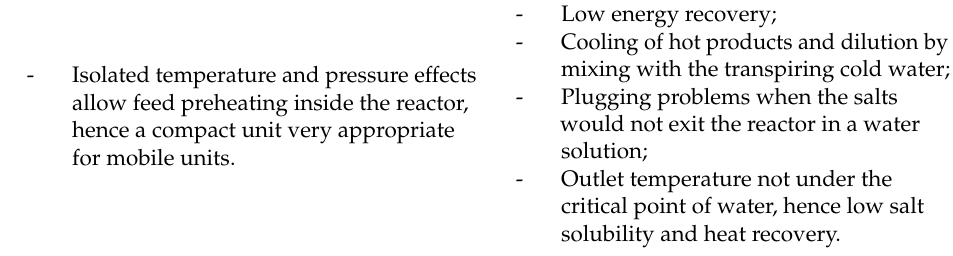
Table 5. Comparison of advantages and disadvantages of the described reactors. Figure Main Advantages Main Disadvantages - Easy implementation by simple available tube soldering; - Suitable for high pressure due to Figure 9 high-rise area compared to volume; - Control of the residence time of the effluent and its conversion rate. - Reduced corrosion problems, overcoming salt deposition; Figure 10 - Achieved short residence times required by hydrothermal oxidation using high flow rates - Particularly sensitive to the problem of Figure 11 solid deposits and clogging, due to very high fluid velocities; - Good control of the exothermic heat of reaction and thus treat a larger quantity Figure 12 of waste; - Tubular reactor with multi-injections of oxygen - Isolated temperature and pressure effects allow feed preheating inside the reactor, Figure 13 hence a compact unit very appropriate for mobile units.